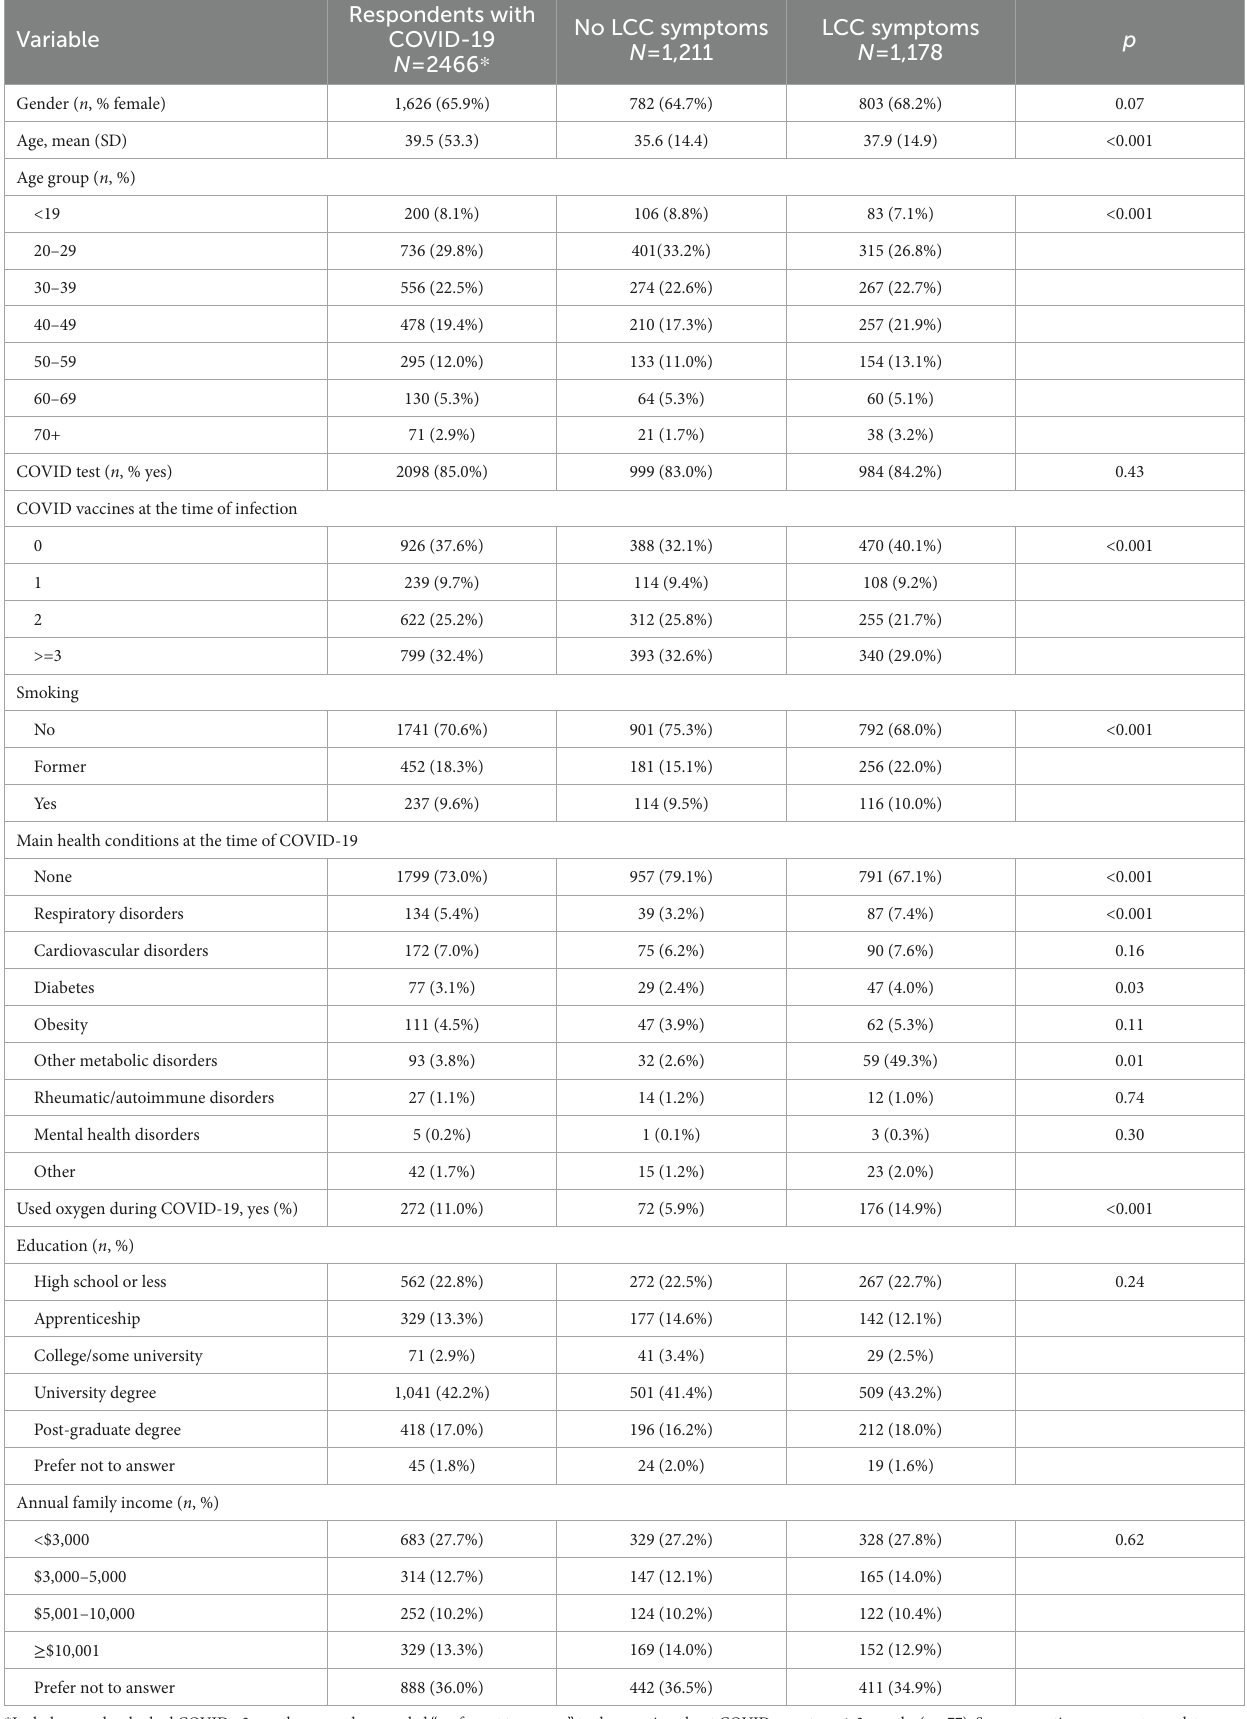
TABLE 1 Characteristics of survey respondents with and without long COVID condition (LCC). Variable